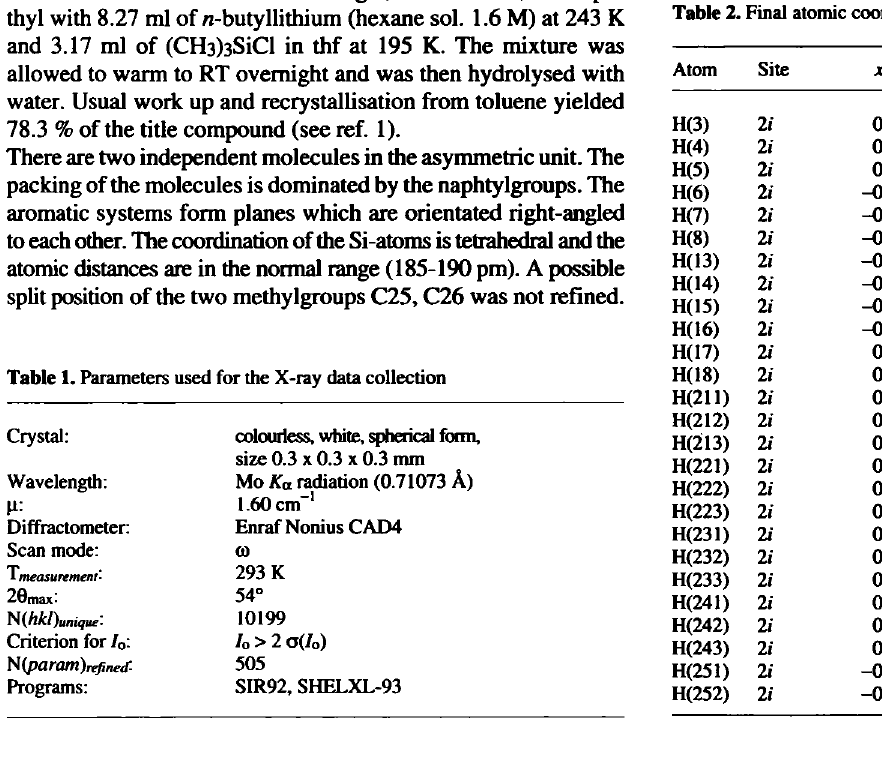
Table 2. Final atomic coordinates and displacement parameters (in Â 2